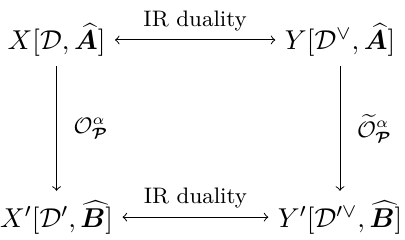
Figure 2 . Generating new dual pairs with defects using an elementary S -type